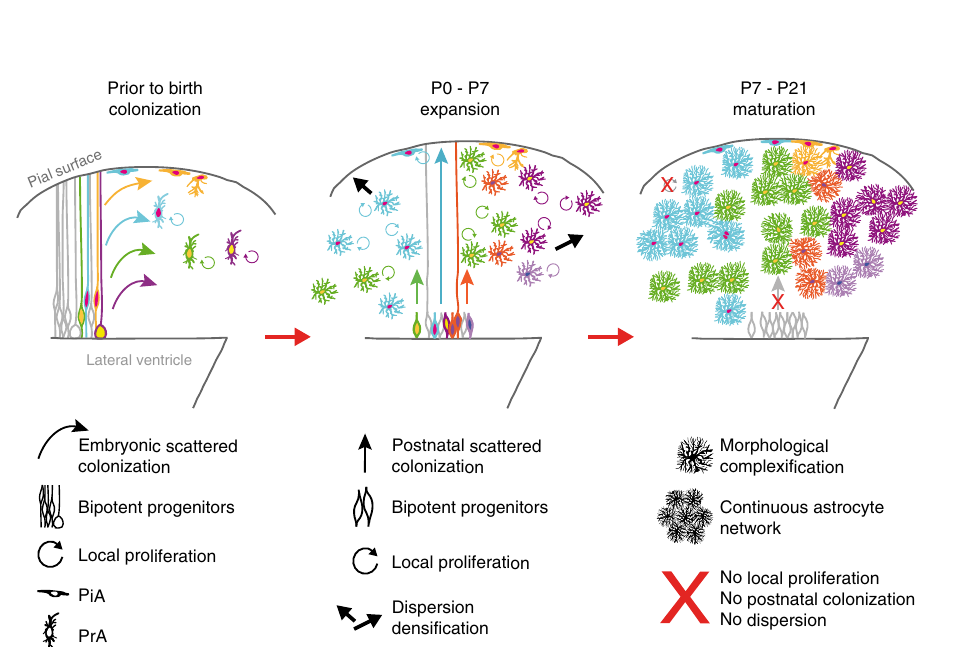
Fig. 6 Comprehensive model for astrocyte development in the mouse cortex. Until now the accepted model of mouse cortical astrocyte development consisted of a fi rst phase where embryonic progenitors colonize the neocortical wall followed by a second step relying on local proliferation of these fi rst settlers after birth, the contribution of postnatal progenitors being debated. Here, we propose that mouse cortical astrocytes are issued from a dual contribution of delaminated embryonic apical progenitors and early postnatal progenitors that both generate pial (PiA) and protoplasmic (PrA) astrocytes. Furthermore, our data show that during the fi rst postnatal week (P0 – P7) both pre- and postnatal progenitors scatter throughout the neocortical wall while proliferating. This dynamic phase is followed by a maturation phase (P7 – P21) where the clones stop both expansion and proliferation while individual astrocytes increase their volume and the complexity of their